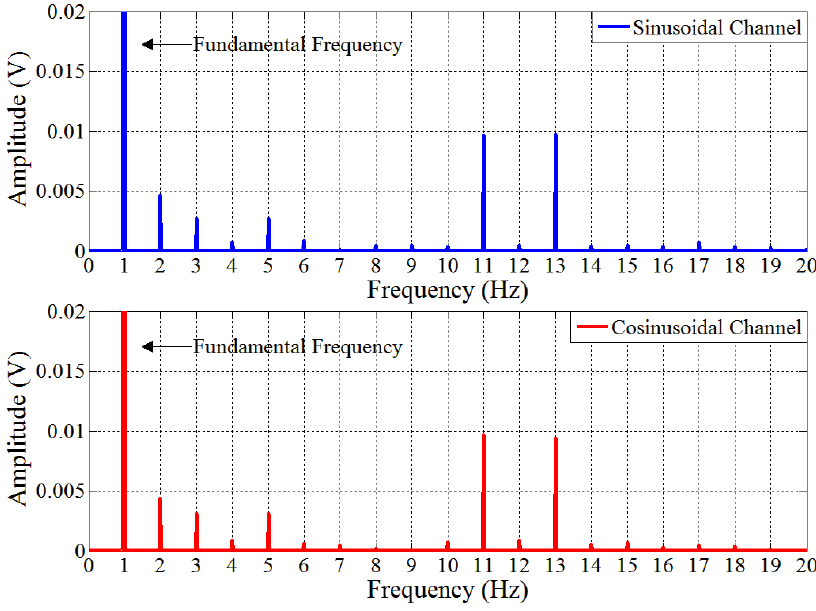
Figure 13. Spectrum of resolver signals at fixed speed in experiment.